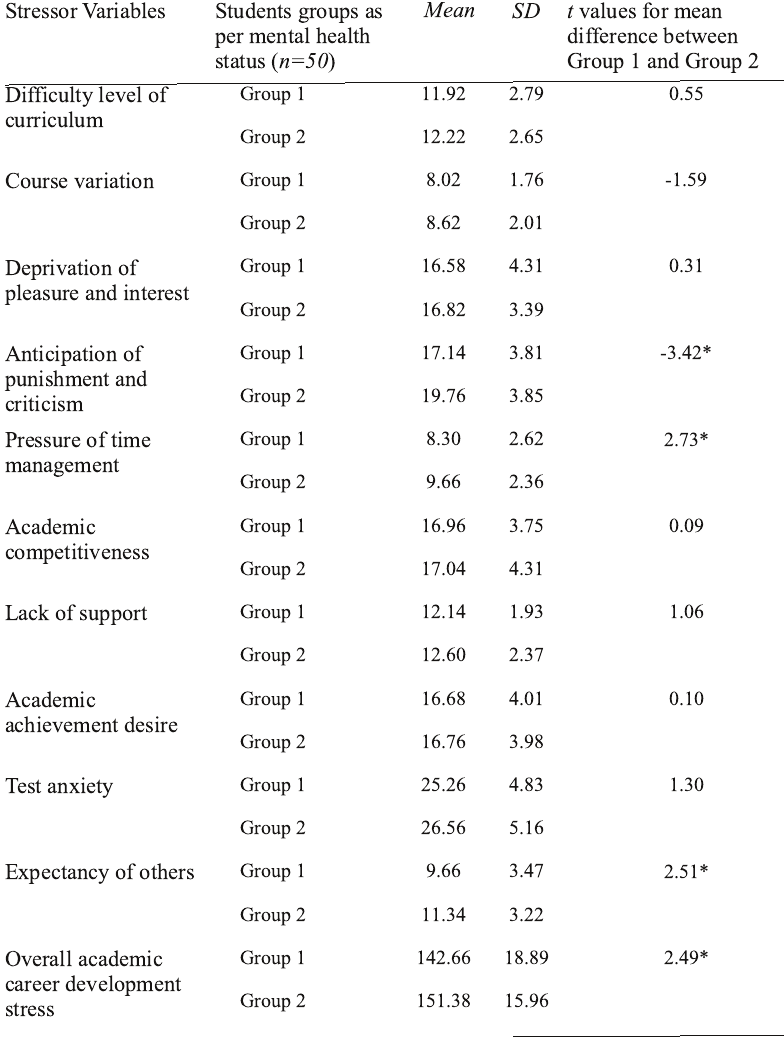
Results of t values on Academic Stressor Variables scores for mean values of the two groups ofstudents (Group 1 for Normal and Group 2 for Problem cases as per General Health Questionnaire,